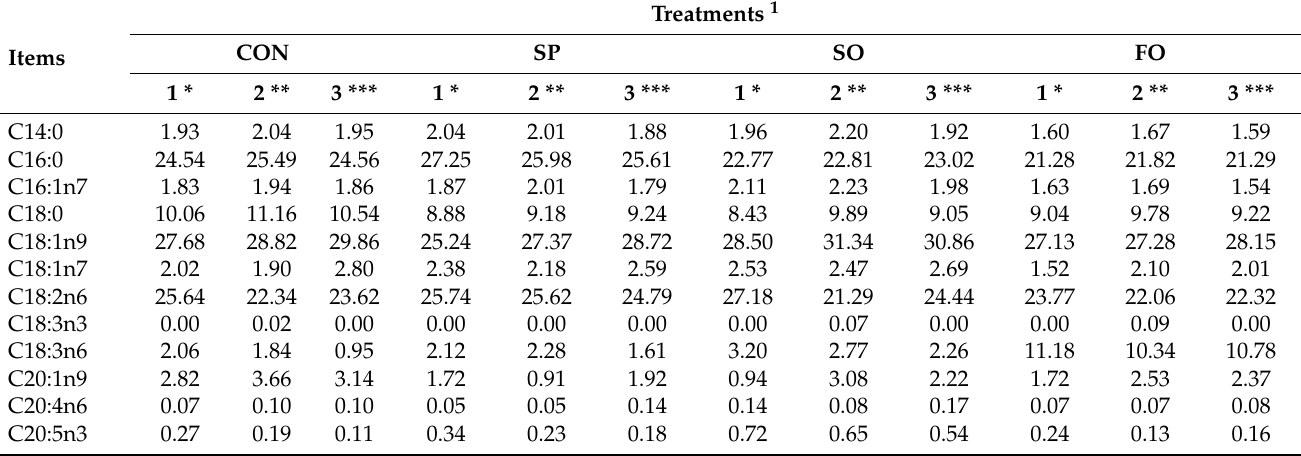
Table 3. Fatty acids contents (% of total fatty acids) of starter * , grower ** , and finisher ***